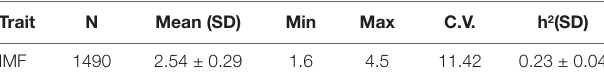
TABLE 1 | Phenotype and heritability statistics for IMF in Duroc